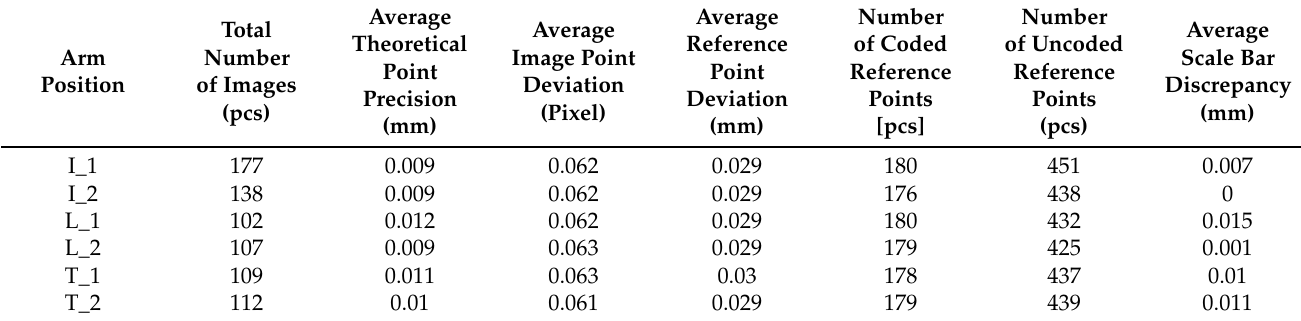
Table 2. Photogrammetry